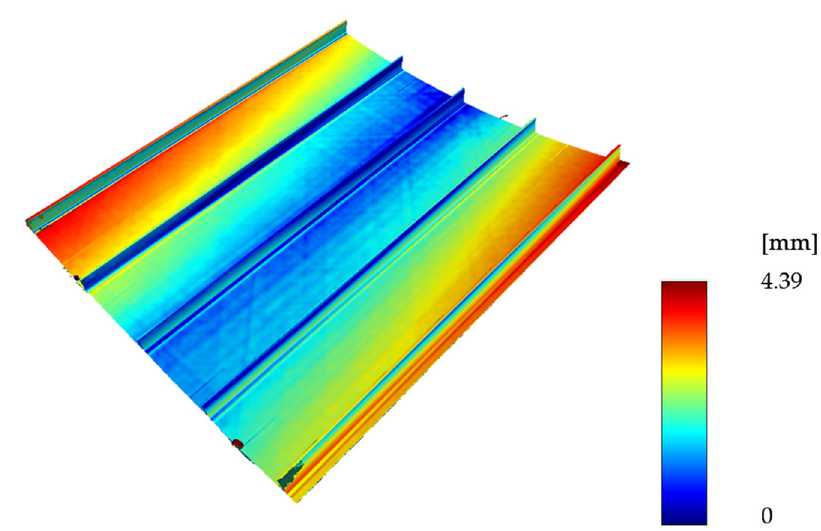
Figure 10. Comparison of the GOM ATOS scan with the reference geometry.